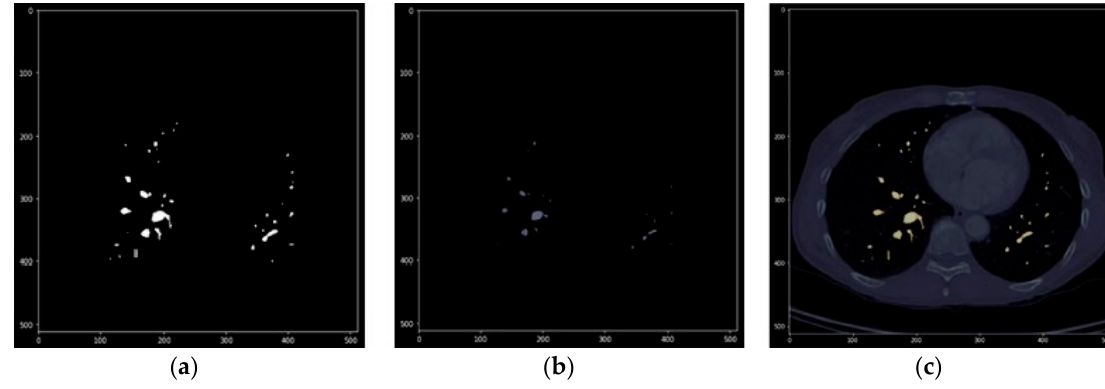
Figure 12. Segmentation of pulmonary veins and arteries. ( a ): Binary mask; ( b ): DICOM with binary